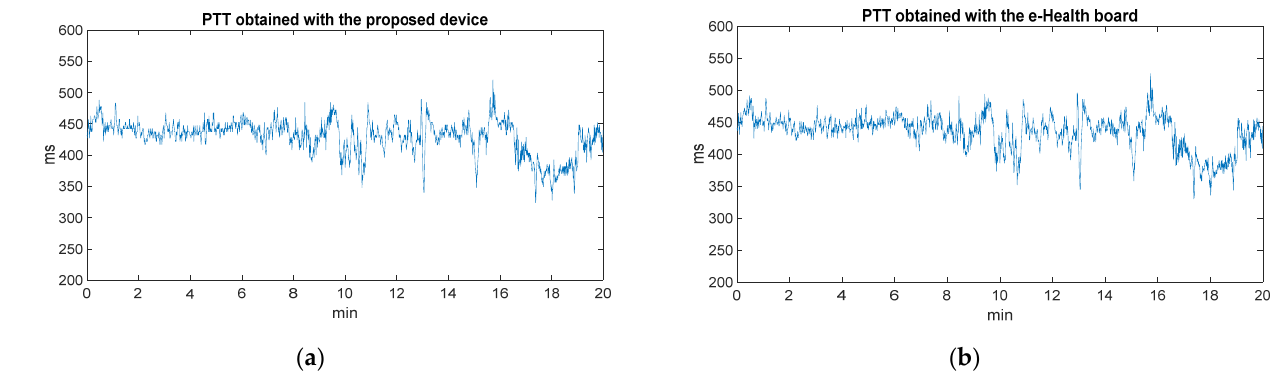
Figure 14. ( a ) Variation of PTT parameter values obtained with the developed device; ( b ) Variation of PTT parameter values obtained with Zephyr Bioharness.